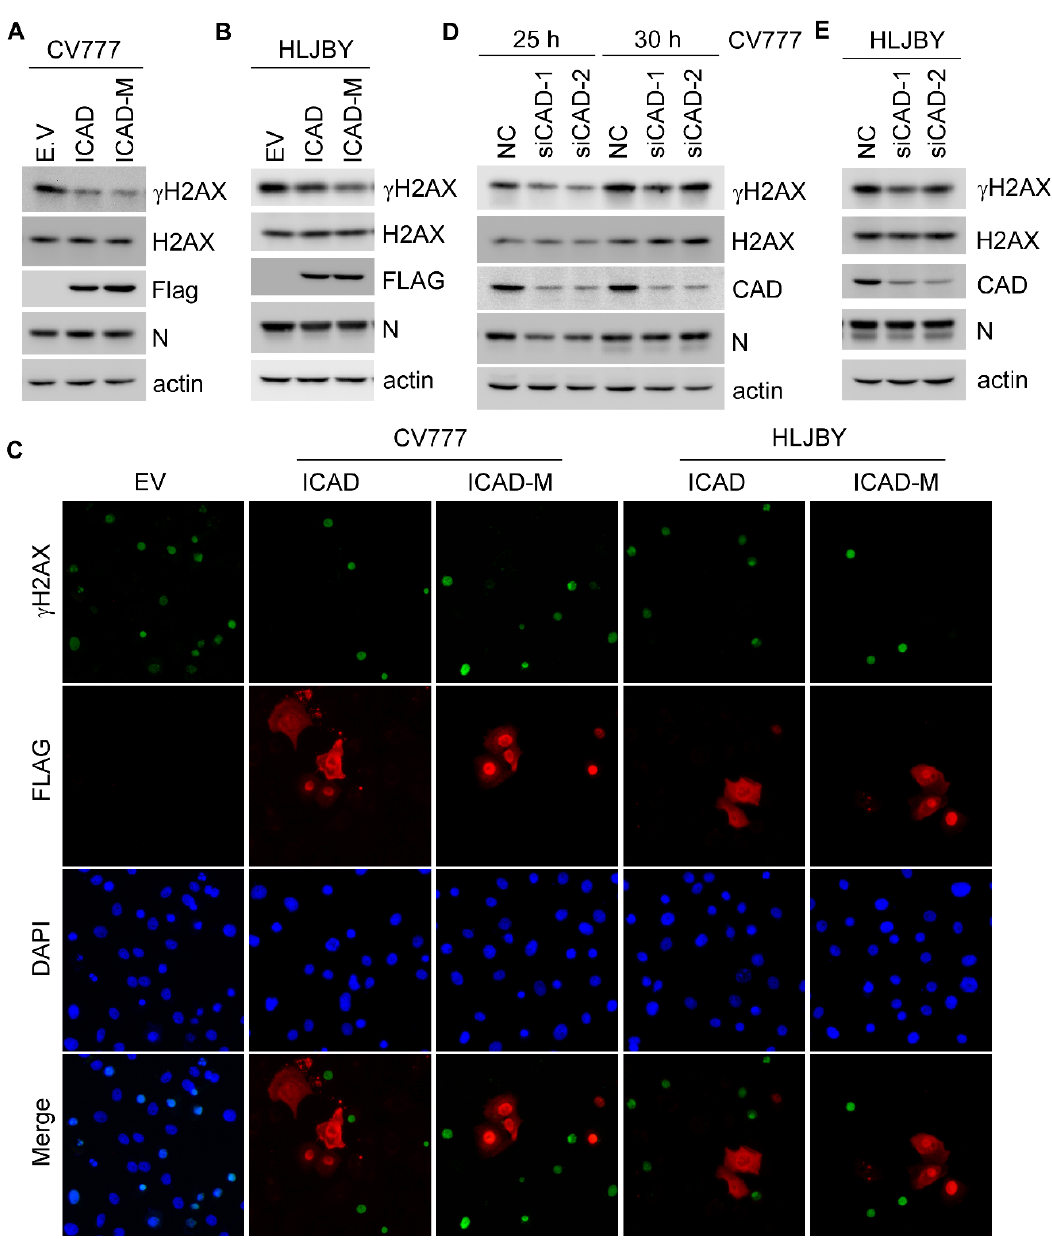
Figure 6. CAD implicates in PEDV ‐ induced H2AX phosphorylation. ( A , B ) Western blots were pre ‐ pared with extracts from Vero ‐ E6 cells transiently transfected with empty vector or Flag ‐ tagged ICAD or ICAD ‐ M (D117E, D224E) for 30 h, followed by 1 MOI CV777 (A) or HLJBY (B ) infection for 25 h. ( C ) IFA was performed with Vero ‐ E6 cells transiently transfected with empty vector or Flag ‐